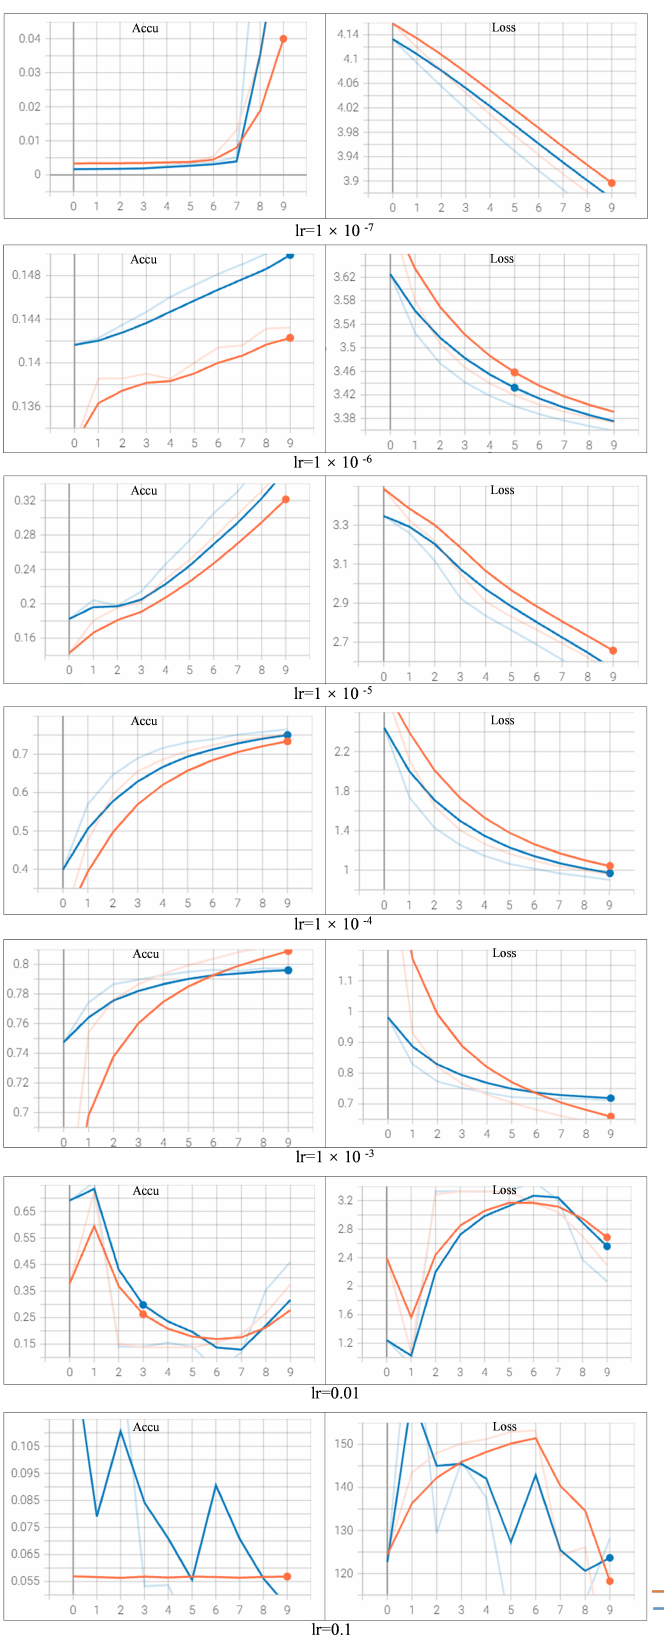
Figure A2. Training and validation performance with different learning rates on SGD optimizer over 10 epochs using the transformers-based